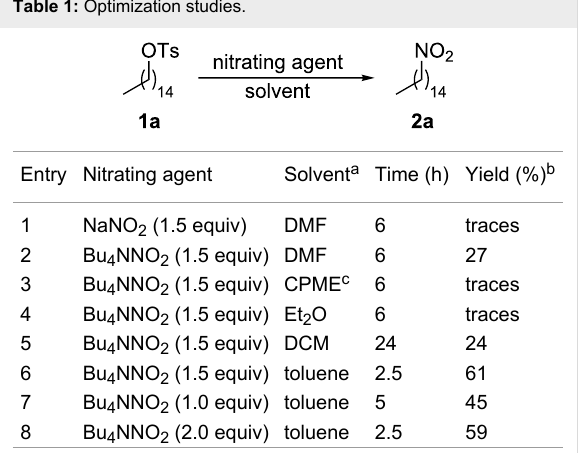
However, although the first step ( a into b ) can be usually performed in quantitative yields, the main drawbacks, in terms of waste production and energy consumption, are in the two- step conversion of b into d .